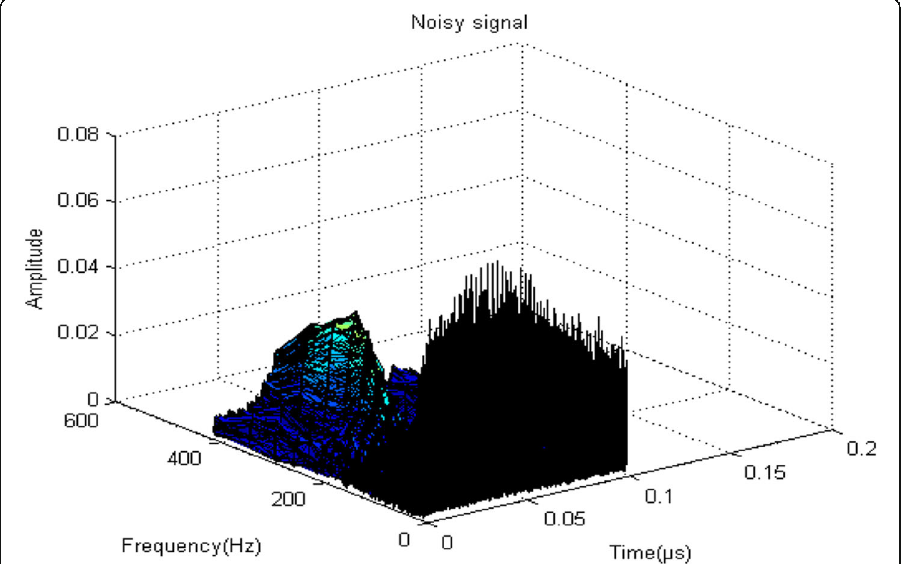
Fig. 8 Time-frequency diagram of noise-added simulation signal